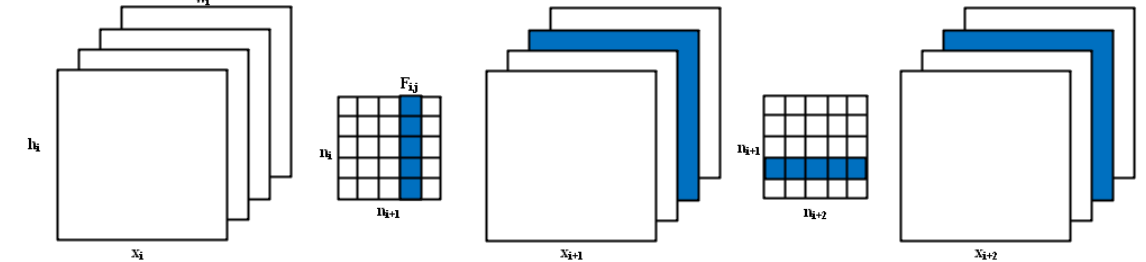
Figure 6. Channel pruning principle. x i denotes the i-th convolutional layer of the network; h i ,w i denote the height and width of the input feature map respectively; n i is the number of input channels of this convolutional layer.